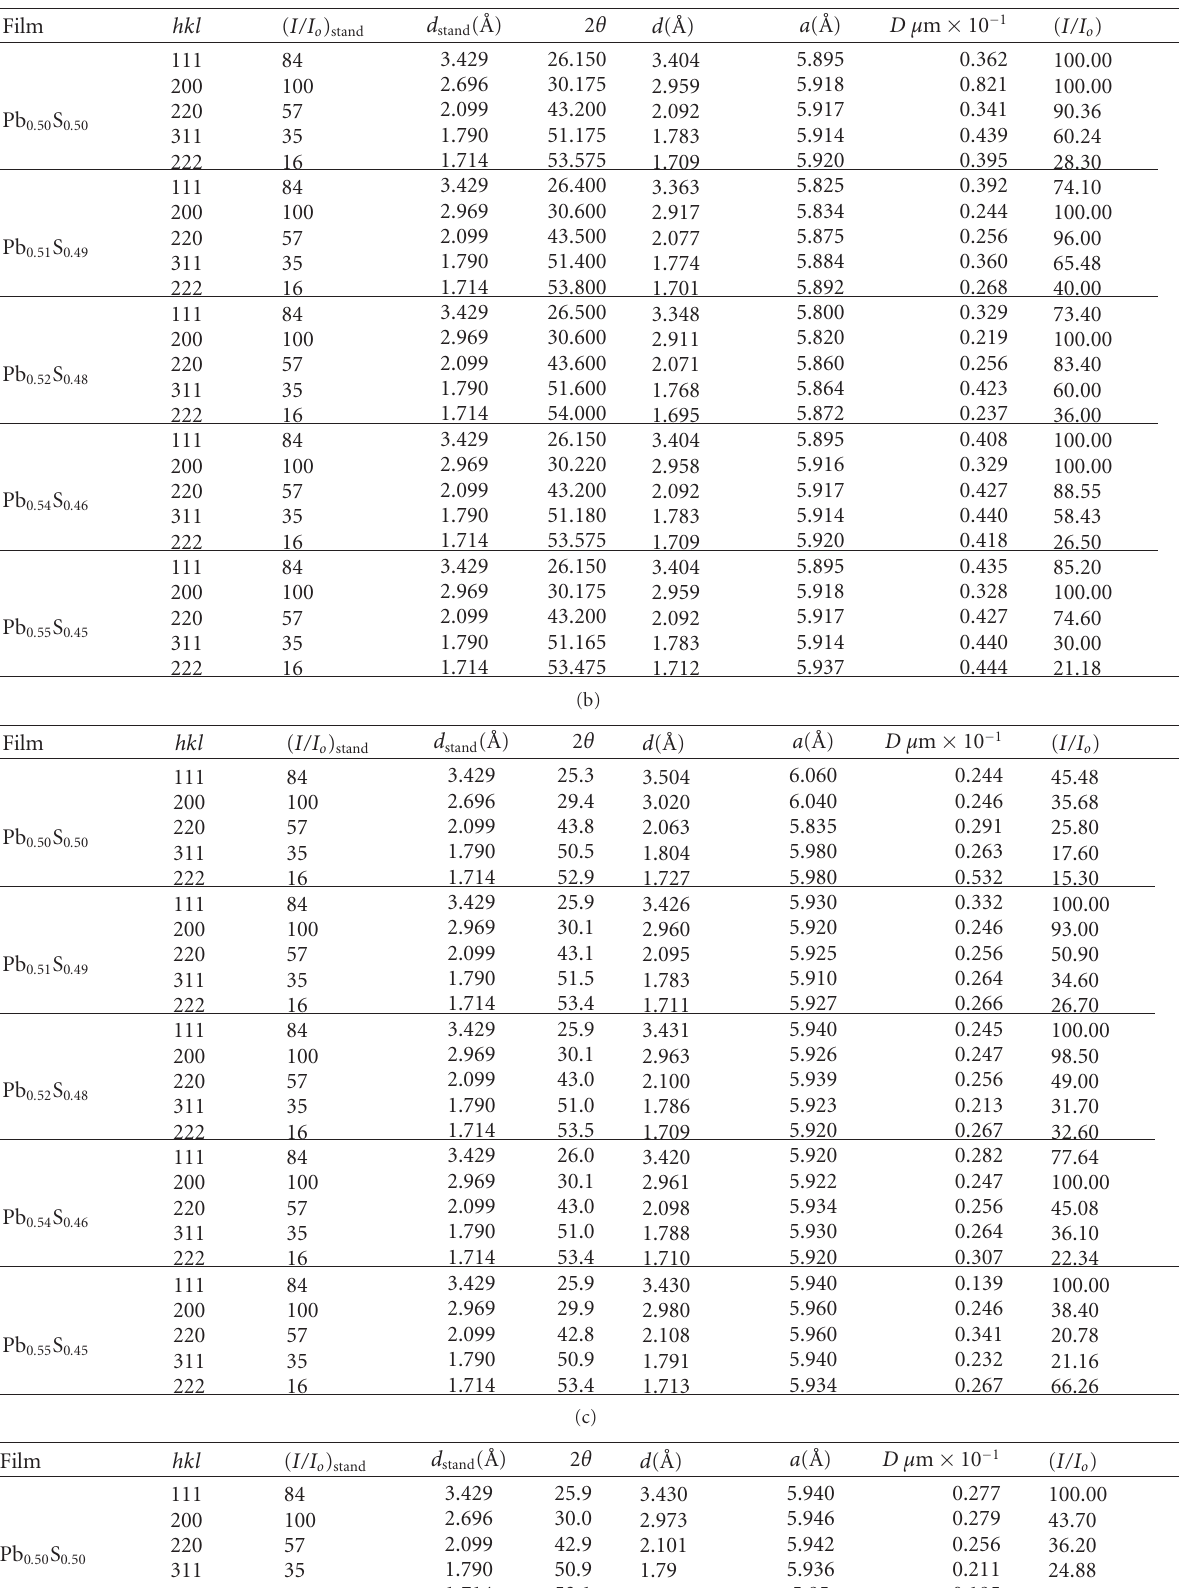
Table 3: X-ray di ff raction data for (a) unannealed (RT) and annealed Pb x S 1 − x films (b) T a = 373 K (c) T a = 523